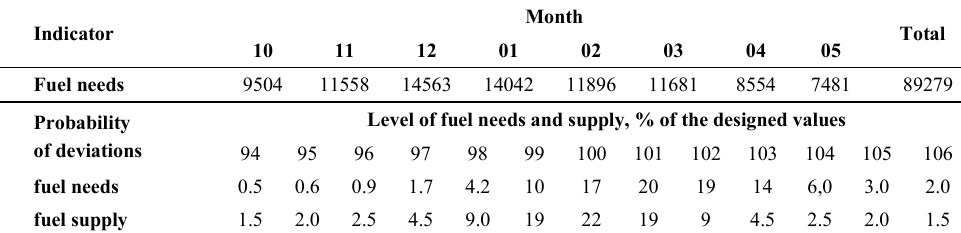
Fig. 5. Distributions of probabilities of random values of needs and supplies of fuel.